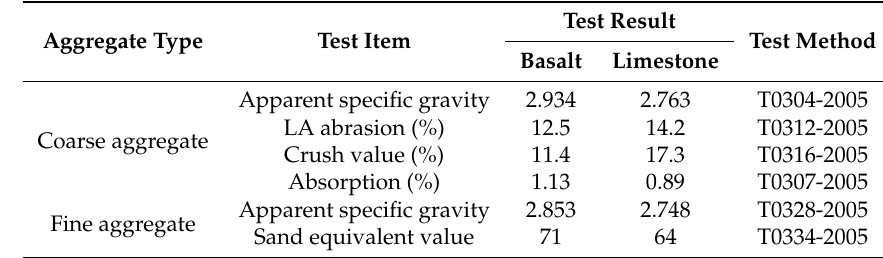
Table 3. Properties of the virgin aggregates.